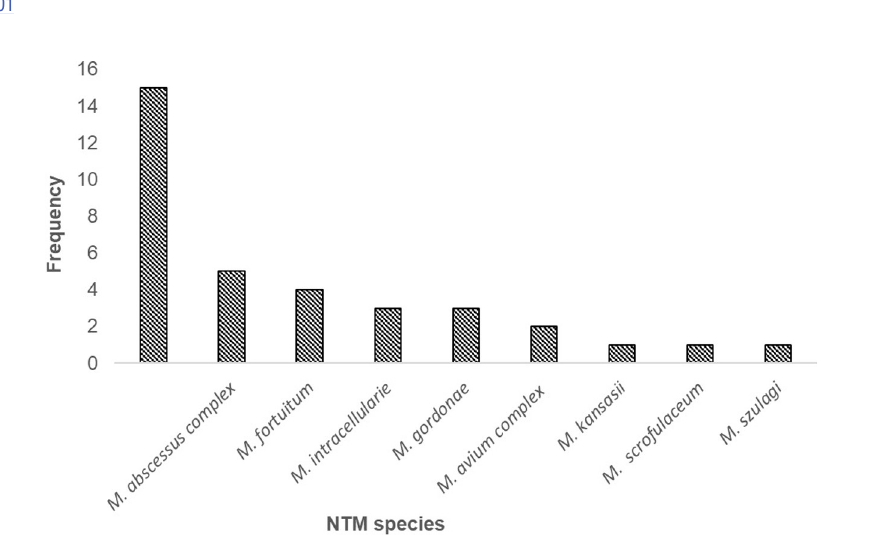
Fig 2. NTM species isolated from PTB patients at EPHI,